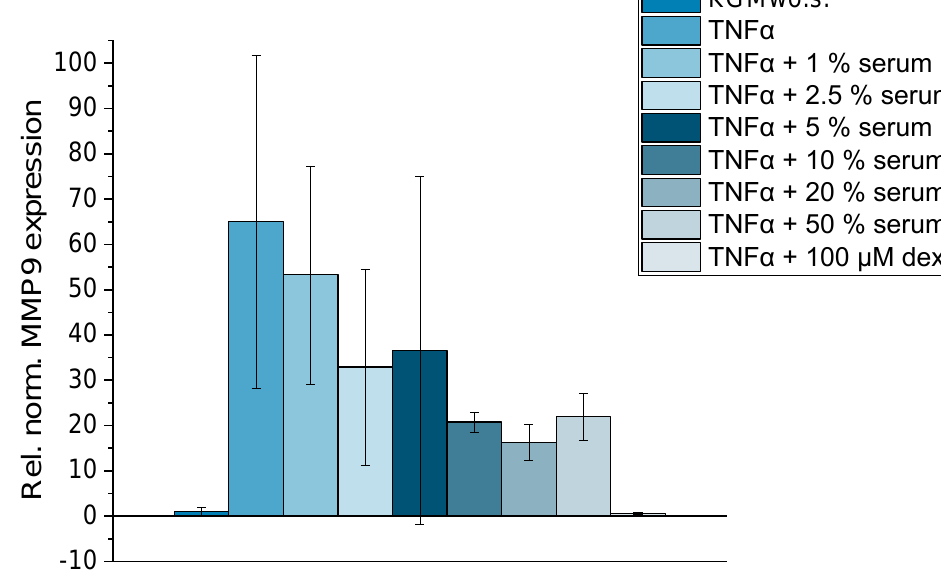
Figure 9. Relative normalized gene expression of MMP9 in HCE-T cells; 24 h of cultivation with TNFα (10 ng/mL) in KGMwo.s. medium with different serum concentrations: 1%, 2.5%, 5%, 10%, 20%, 50%; 3 wells per sample were analyzed (n well = 3); 2–3 technical replicates were conducted per well (n technical replicate = 2–3); mean ± SD.